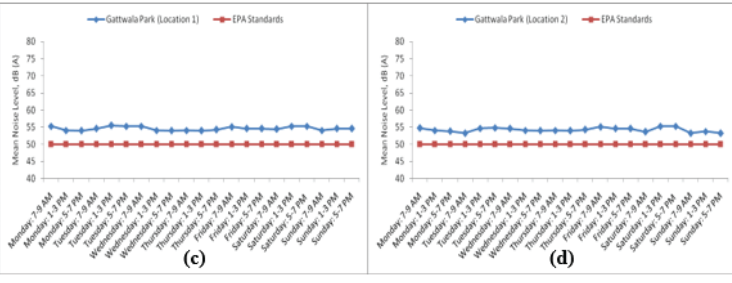
Figure 4: Comparison of Average Noise Level against PEPA Standard (Site